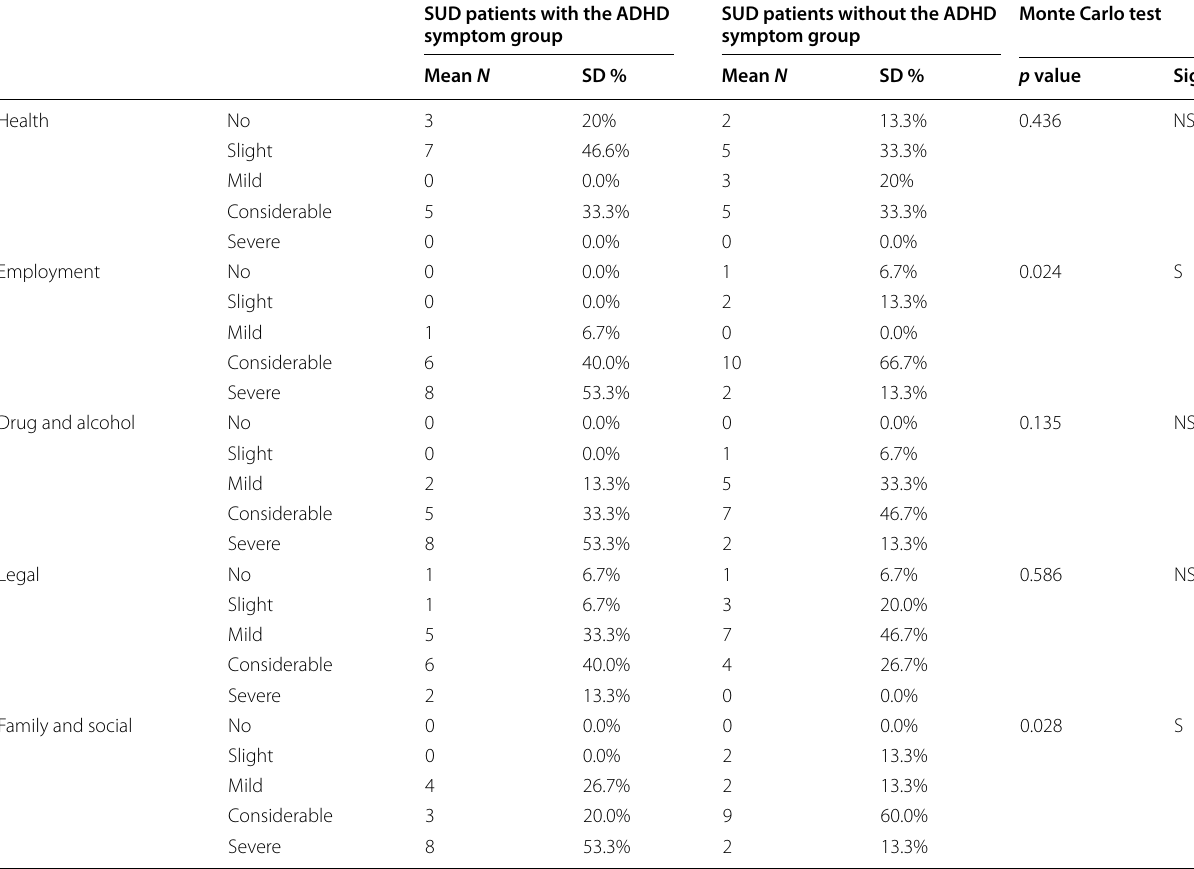
Table 3 Comparison between SUD patients with the ADHD symptom group and SUD patients without the ADHD symptom group as regards addiction severity index components